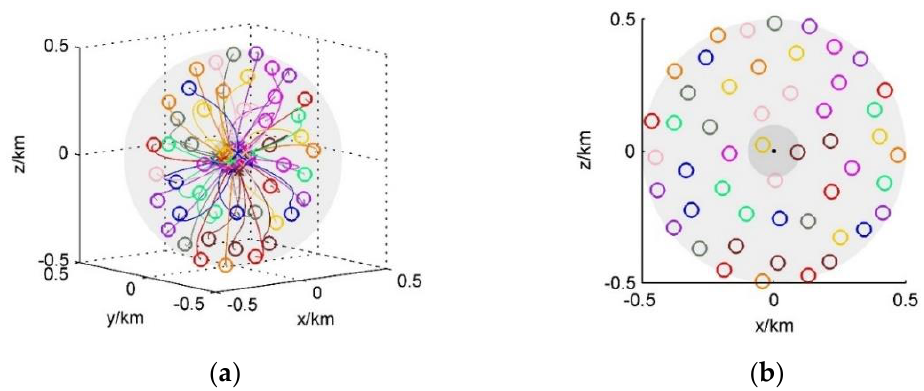
Figure 18. The in-plane disk formation ( r = 0 km, µ = − 1 km). ( a ) Relative motion trajectory in 0-2000